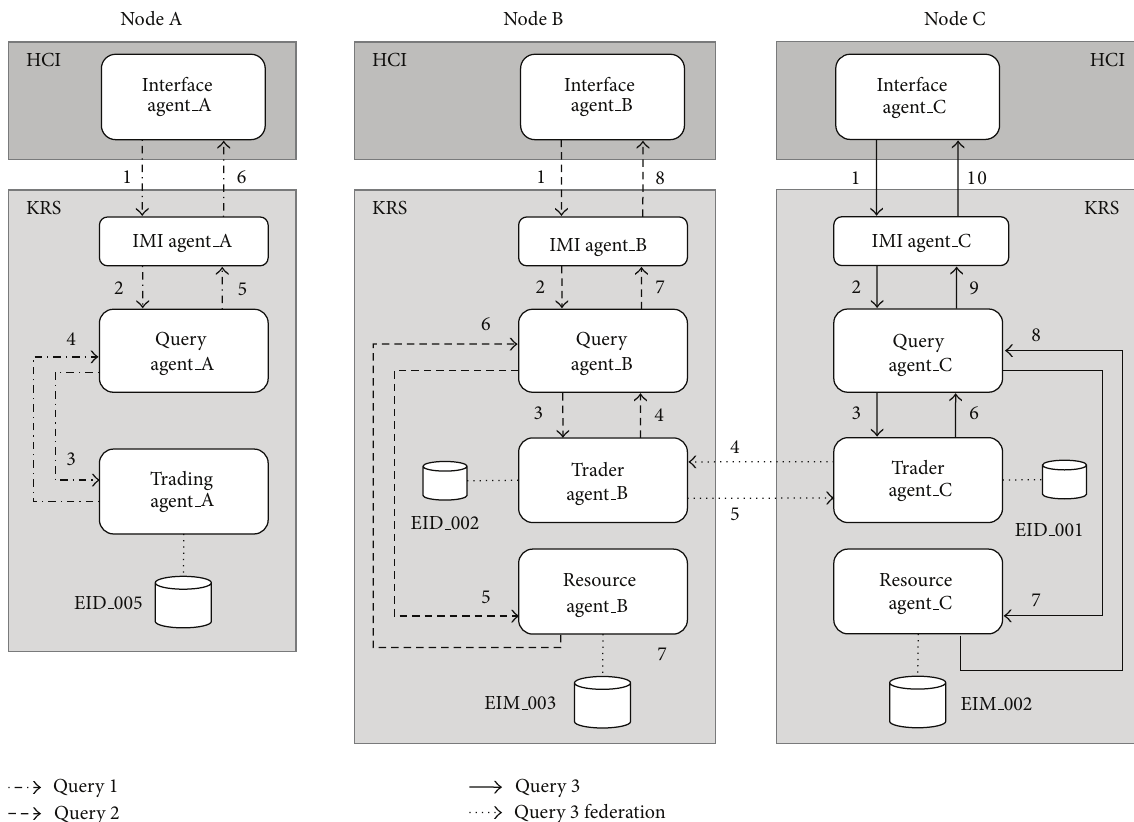
Figure 10: The three main scenarios (reflection, delegation, and federation).